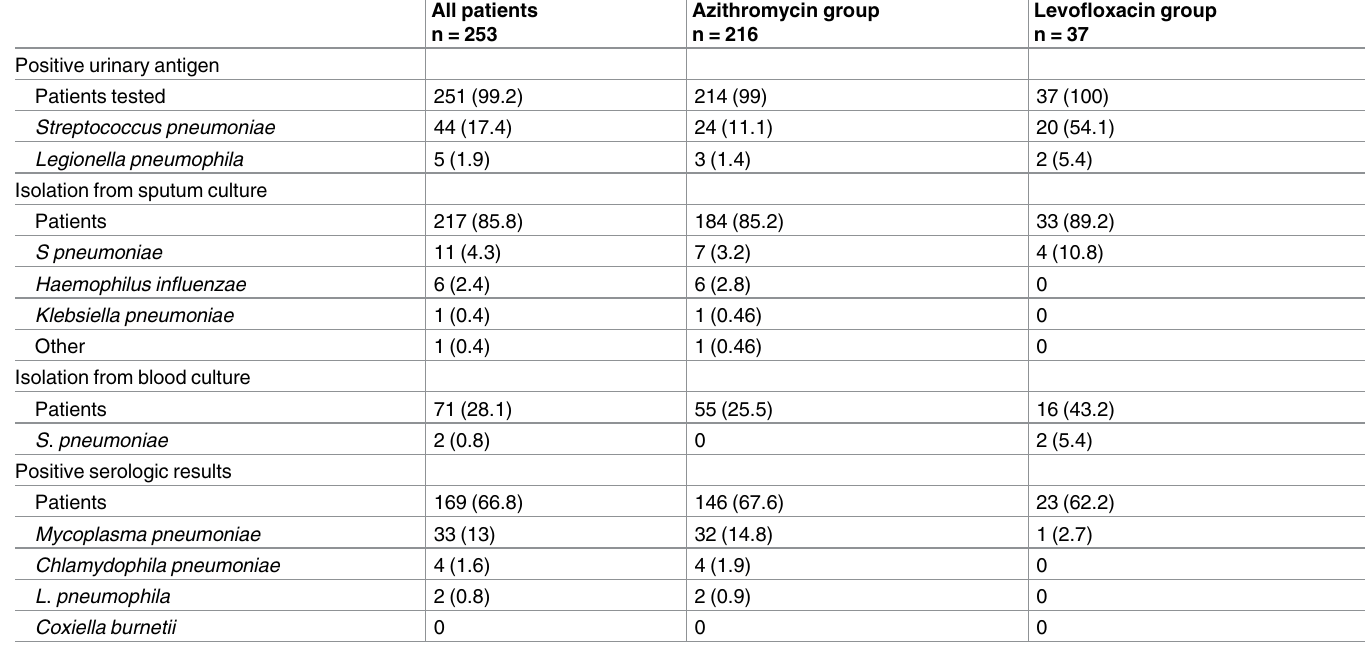
Table 2. Etiological agents identified by treatment group.